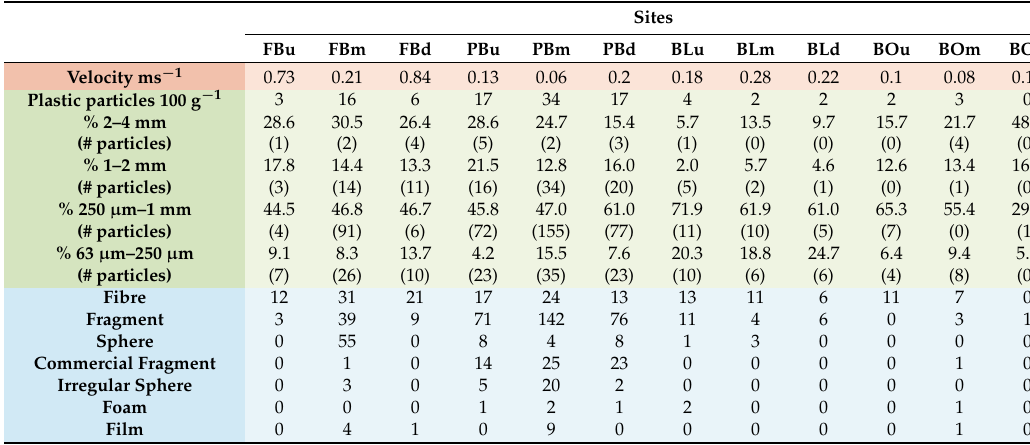
Table 2. Plastic particle abundance, proportion of sediment within each size fraction (# = number of plastic particles within each size fraction), flow velocity at time of sample collection and number of plastic particles within each shape class for the sample sites from the tributaries of the River Tame. The subscripts u, m, and d refer to upstream, middle and downstream samples at each site. FB is an urbanized tributary fed by effluent from two WwTw; PB is an urbanized tributary with no WwTw effluent; BL is a largely rural tributary with WwTw effluent from Barston WwTw; RB is a rural tributary with no WwTw effluent. See Figure 1 for the location of each sample site.